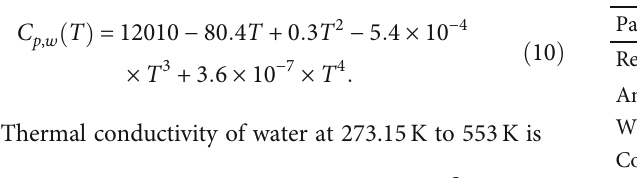
Figure 4: Relationship between Reynolds number and mass fl ow rate. Table 1: Value of simulation